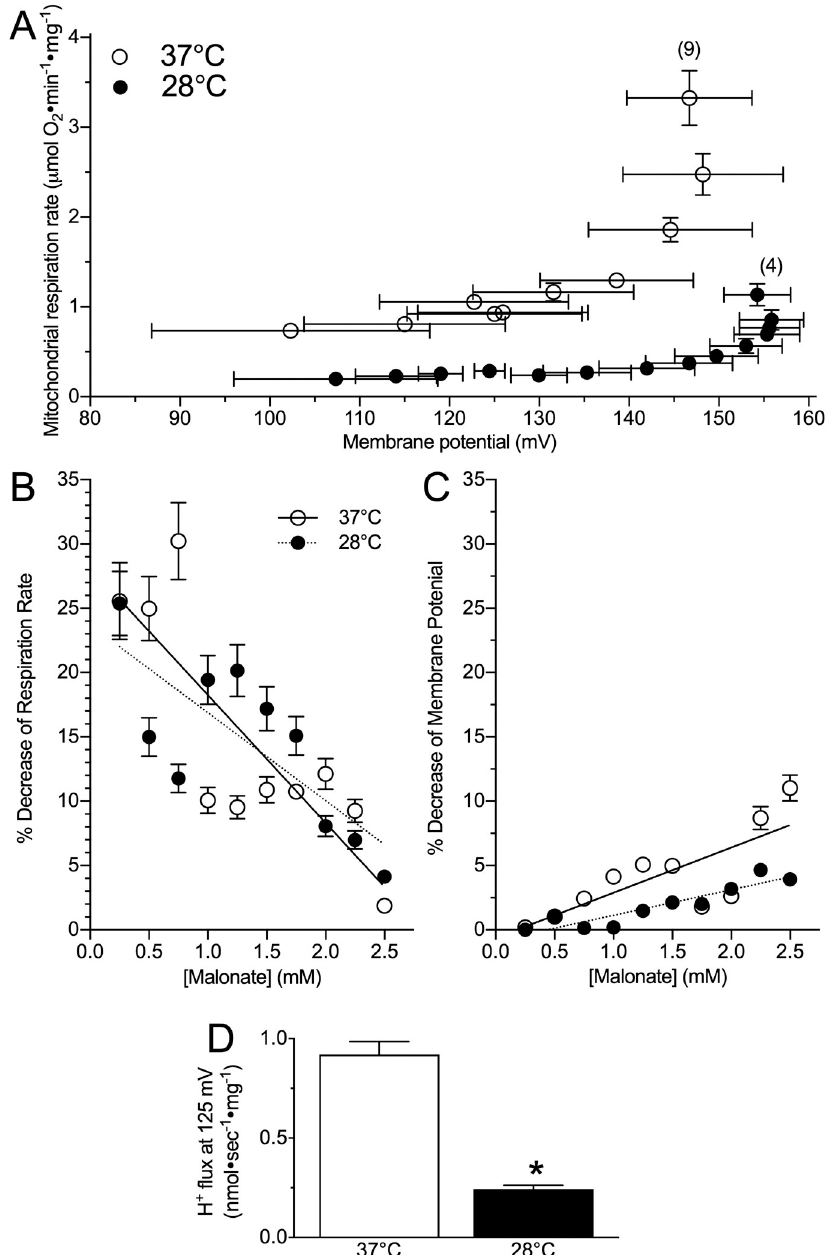
Fig 3. The mitochondrial H + gradient of hypothermic brain mitochondria is reduced relative to physiological temperature. (A) Hypothermic (black circles) brain H + flux and oxygen consumption are equally coupled but reduced in magnitude relative to at physiological temperature (open circles). (B) Percent decrease of mitochondrial respiration, and (C) mitochondrial membrane potential with step-wise addition of malonate. (D) Comparison of H + flux rates at a common mitochondrial membrane potential of 125 mV. The temperature co-efficient (Q 10 ) for H + flux at 125 mV is 4.4. Data are mean ± SEM. Numbers in parenthesis indicate n . Asterisks ( � ) indicate significant differences between mice and NMR mitochondria (p < 0.05; see Results section for statistical tests).